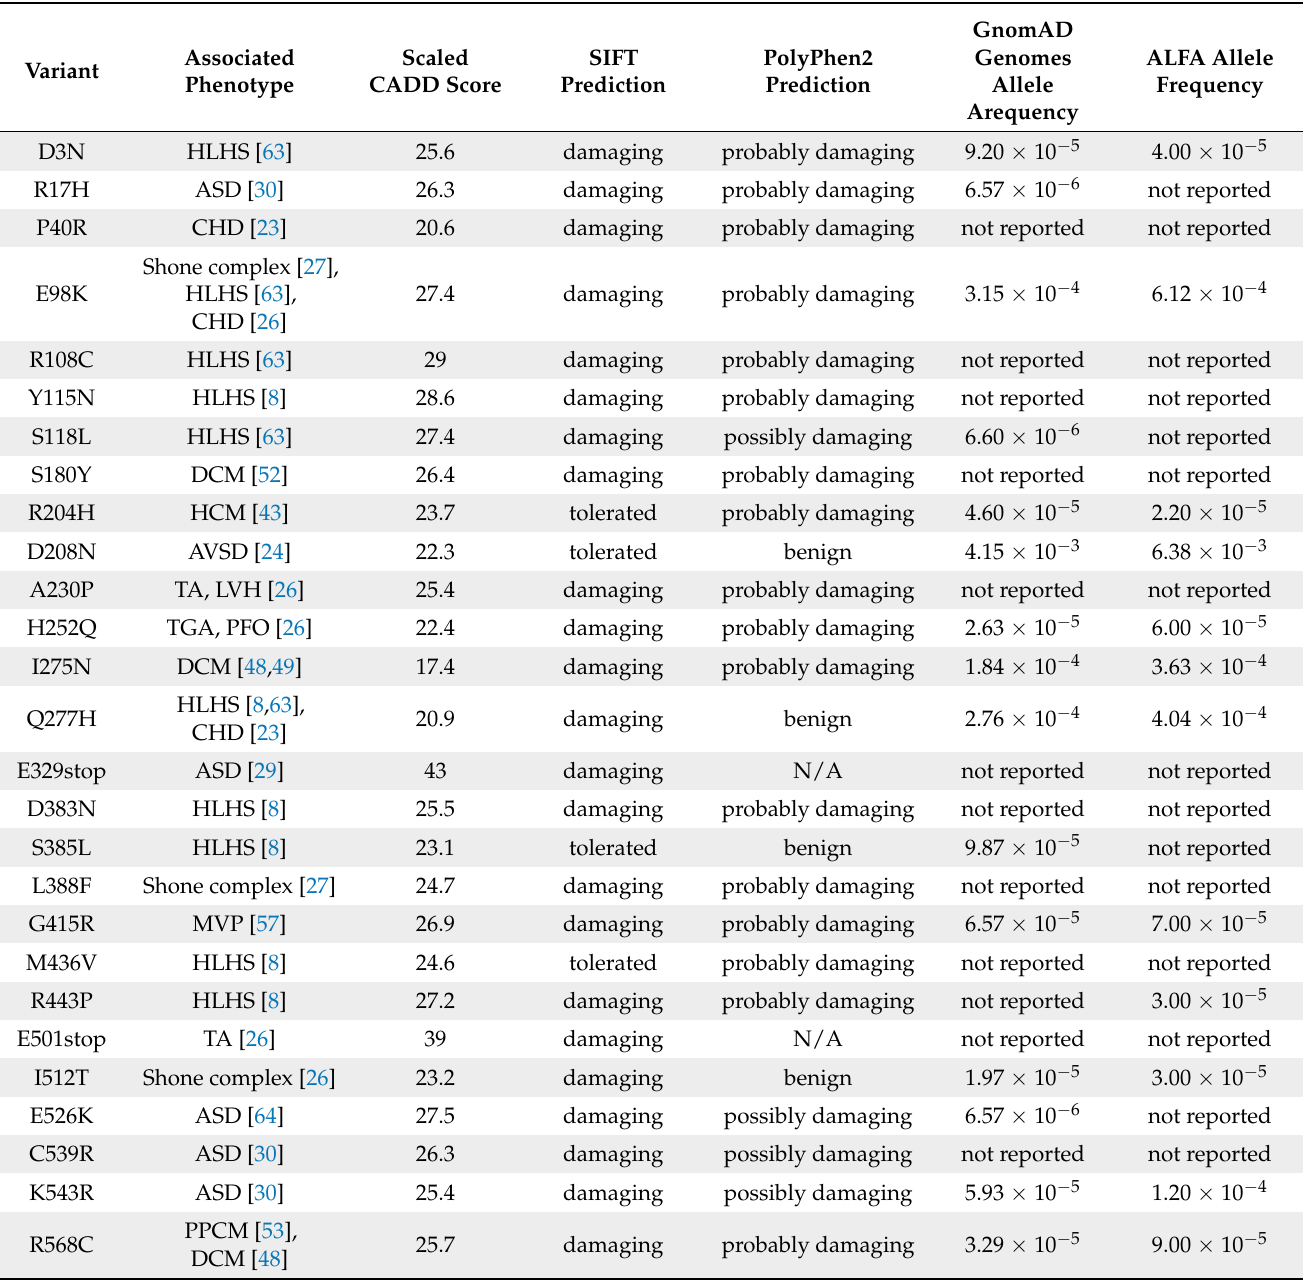
Table 1. Published MYH6 coding sequence variants. Minor allele frequencies were obtained from the Genome Aggregation Database (gnomAD) Genomes dataset v3.1.2 and the Allele Frequency Aggregator (ALFA) dataset (release version 20201027095038). Computational methods used to predict deleterious nature of variants include scaled Combined Annotation Dependent Depletion (CADD) score (GRCh37, v1.6) [60], SIFT [61], and PolyPhen2 [62]. Not all computational methods were able to calculate potential pathogenicity scores for truncating variants or deletions. Abbreviations : HLHS, hypoplastic left heart syndrome; ASD, atrial septal defect; CHD, unspecified congenital heart disease; DCM, dilated cardiomyopathy; HCM, hypertrophic cardiomyopathy; TA, tricuspid atresia; LVH, left ventricular hypertrophy; TGA, transposition of the great arteries; PFO, patent foramen ovale; MVP, mitral valve prolapse; PPCM, peripartum cardiomyopathy; SSS, sick sinus syndrome; CoA, coarctation of the aorta; WPW, Wolff–Parkinson–White syndrome; AVSD, atrioventricular septal defect; ARVC, arrhythmogenic right ventricular cardiomyopathy; AF, atrial fibrillation; LVNC, left ventricular noncompaction; SDK, septal dyskinesia; SAR, subaortic ridge; AS, aortic stenosis; DIVC, dilated inferior vena